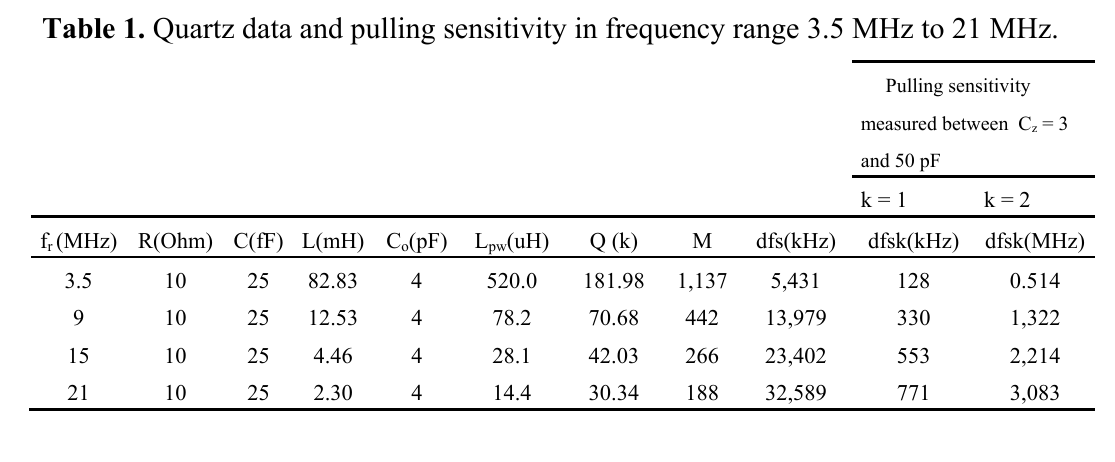
Table 1. Quartz data and pulling sensitivity in frequency range 3.5 MHz to 21